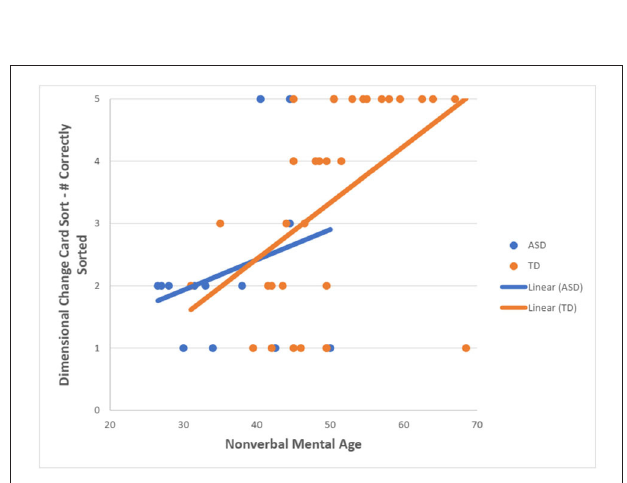
FIGURE 4 | Scatterplot showing the relationship between NVMA and a number of correctly sorted post-switch DCCS trials for both groups.